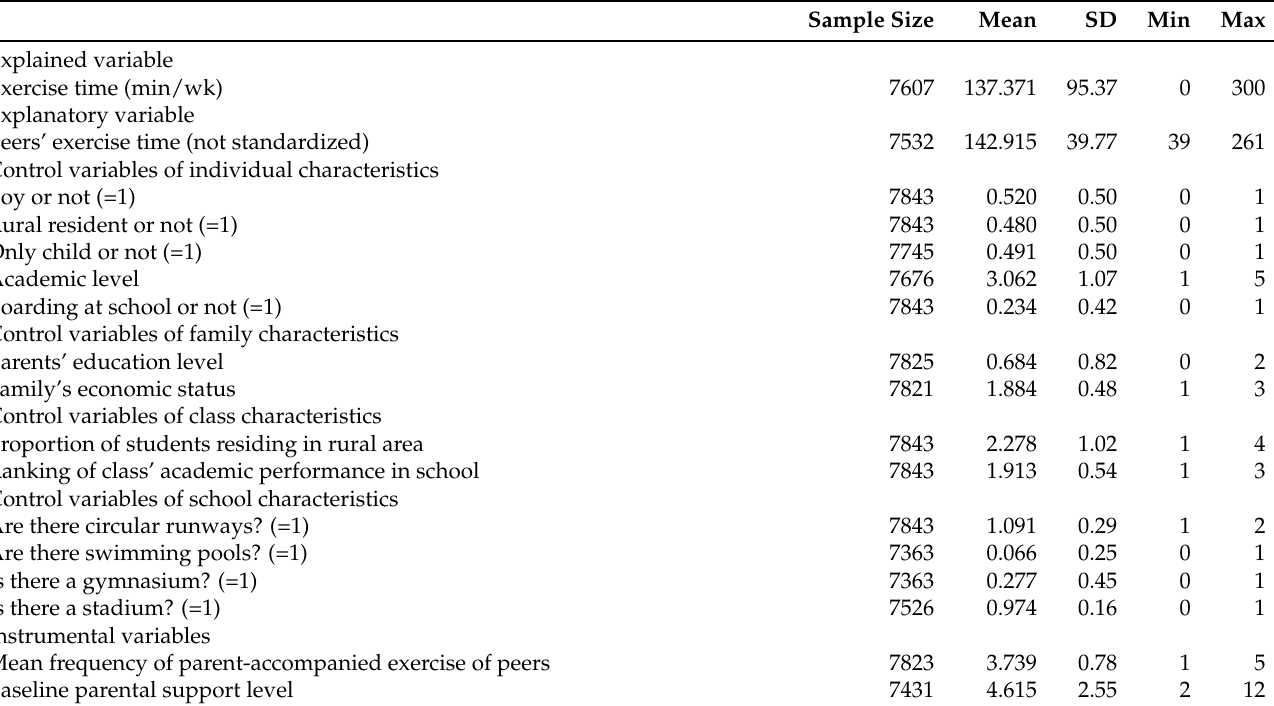
Table 1. Descriptive Statistics of Variables.